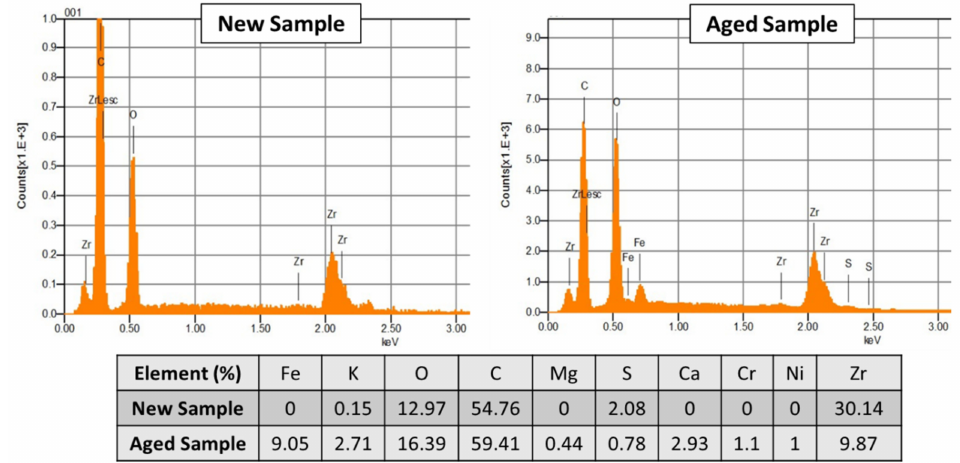
Figure 9. Electron Di ff raction Scattering (EDS) Spectra and elemental composition for new and aged Zirfon ® samples.